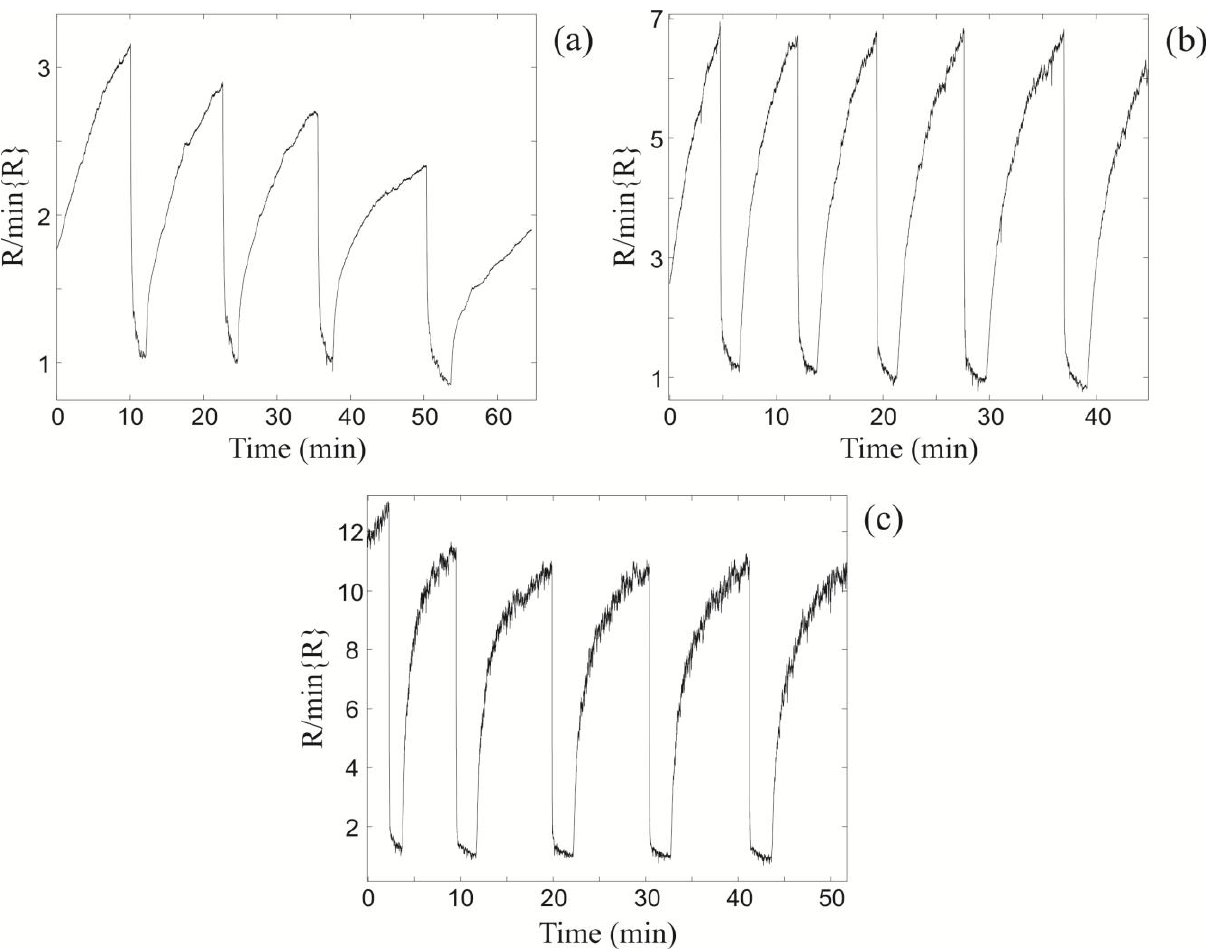
Figure 3. The relative changes in resistance of the light bulb ZnO nanospring sensor at ( a ) T = 280 °C; ( b ) T = 370 °C; and ( c ) T = 435 °C upon exposure to sequential LB LB LB 1000 ppm toluene pulses at fixed vapor-gas temperature T = 22 V